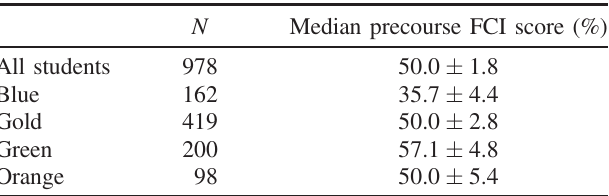
TABLE VI. Median precourse FCI scores.